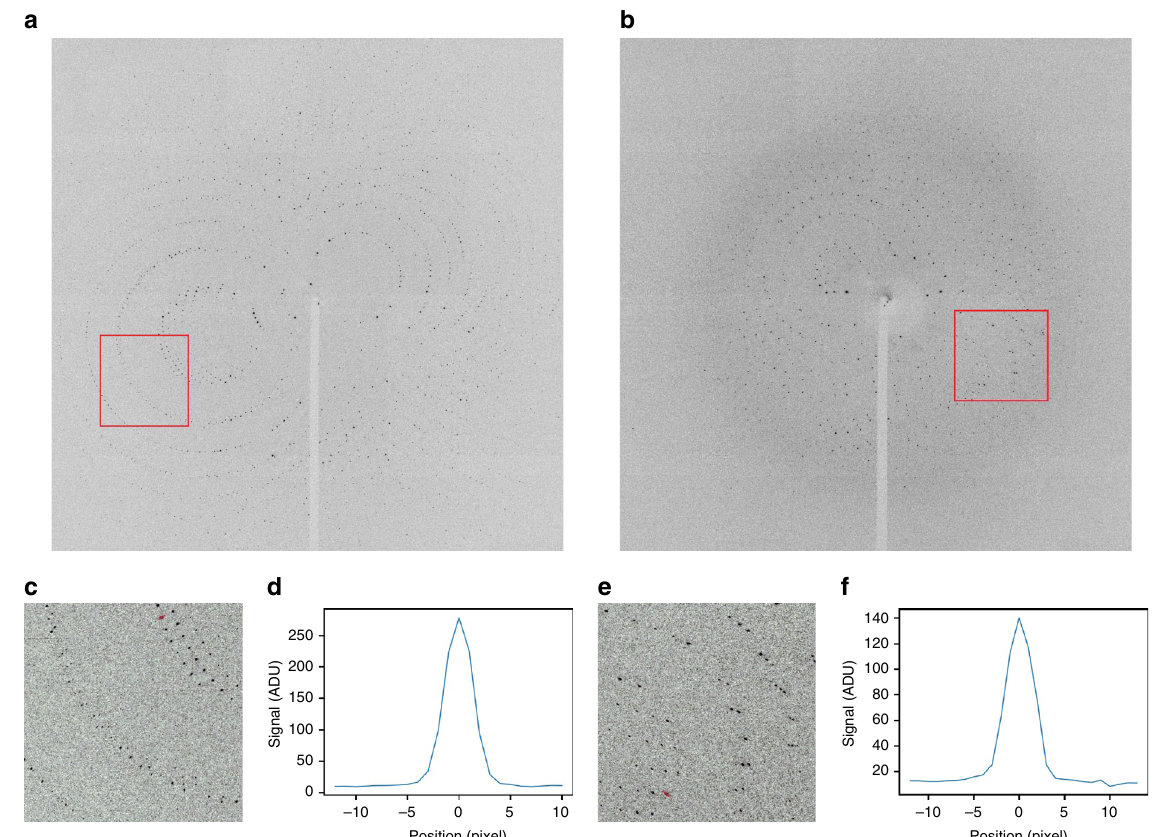
Fig. 1 Exemplary single shot pink-beam diffraction images of a proteinase K and b phycocyanin microcrystals. Data were recorded at the BioCARS beamline using a Rayonix CCD detector. Crystal sizes were between 10 and 20 µ m for proteinase K and 30 and 40 µ m in case of phycocyanin. The diffraction images reveal the absence of a pronounced water ring that is typically observed in diffraction experiments from macromolecular crystals. c , e Insets of sub fi gures a and b , respectively, highlighting the shape of the Bragg spots. d , f Lineouts of the red traces in c and e , respectively, showing the shape of two exemplary Bragg spots from proteinase K and phycocyanin diffraction patterns